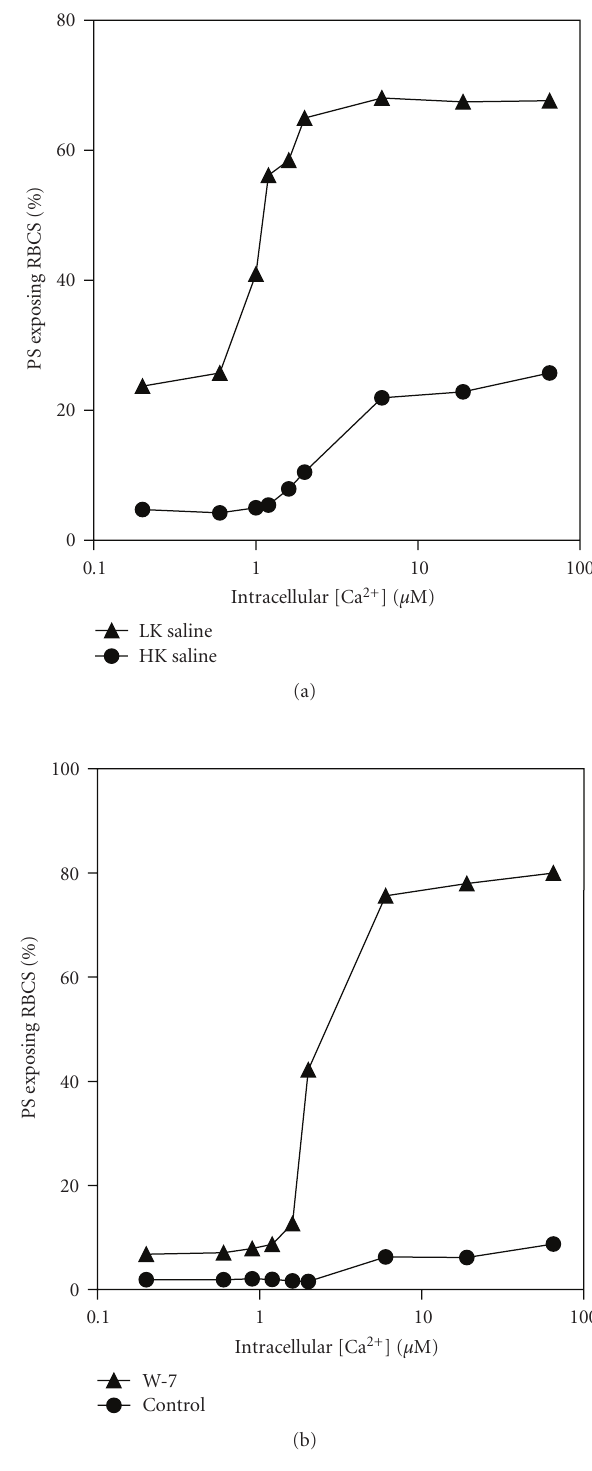
Figure 6: E ff ect of K + and calmodulin inhibition on Ca 2+ -induced exposure of phosphatidylserine (PS) in red blood cells (RBCs) from sickle cell patients. Experimental details were as described in the legend to Figure 4, except that in (a) where incubation was carried out in either high K + -(HK, K + = 90 mM) or low K + -containing saline (LK, 4 mM), and, in (b) where HK saline was used in the absence or presence of W-7 (100 μ M). Results are presented as single experiments representative of 3